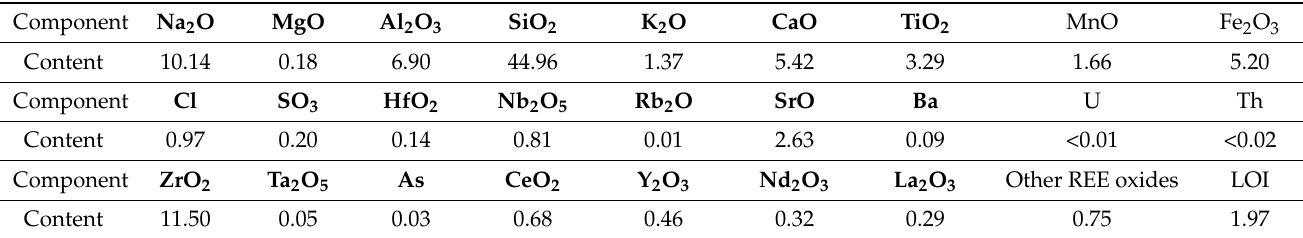
Table 1. Chemical composition of eudialyte concentrate (wt %).